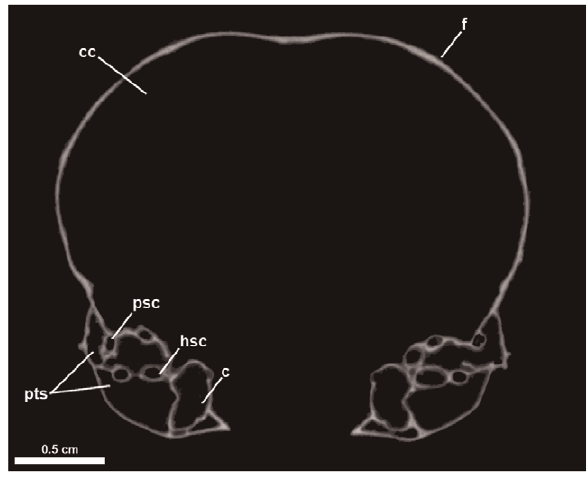
Figure 1. Representative coronal slice through the skull of the Marbled Murrelet Brachyramphusmarmoratus (NCSM 18149).